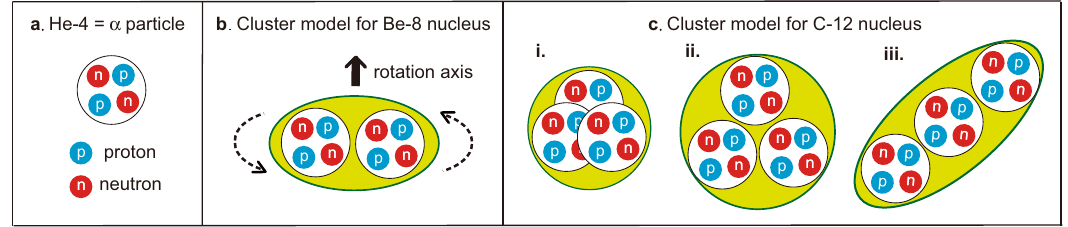
Fig. 1 Schematic illustrations of α clustering in atomic nuclei. a 4 He = α particle, b 8 Be, and c 12 C (three possible cases, i, ii, and iii). The green areas represent atomic nuclei allowing some movements of α